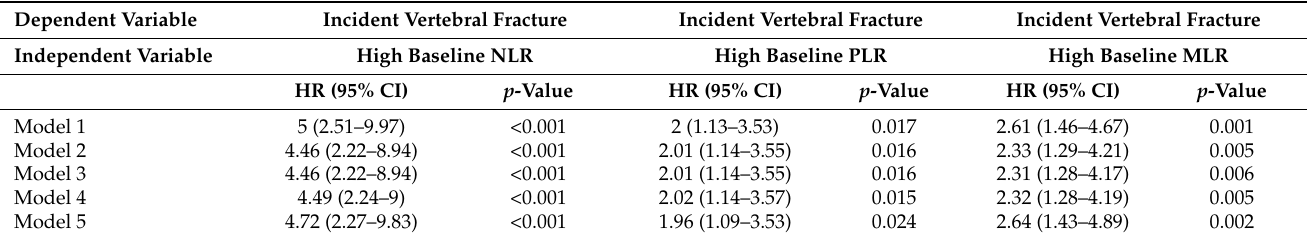
Table 5. Hazard ratios of baseline neutrophil-to-lymphocyte ratio, platelet-to-lymphocyte ratio and monocyte-to-lymphocyte ration for incident vertebral fracture in patients with rheumatoid